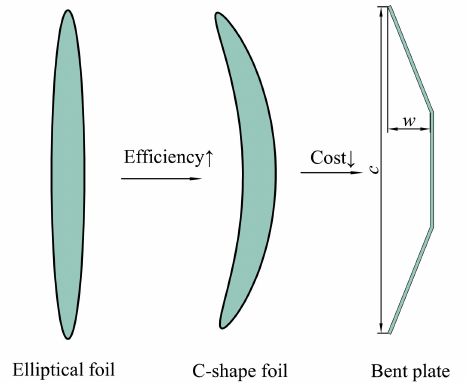
Figure 1. Evolution of the oscillator’s sectional shape.